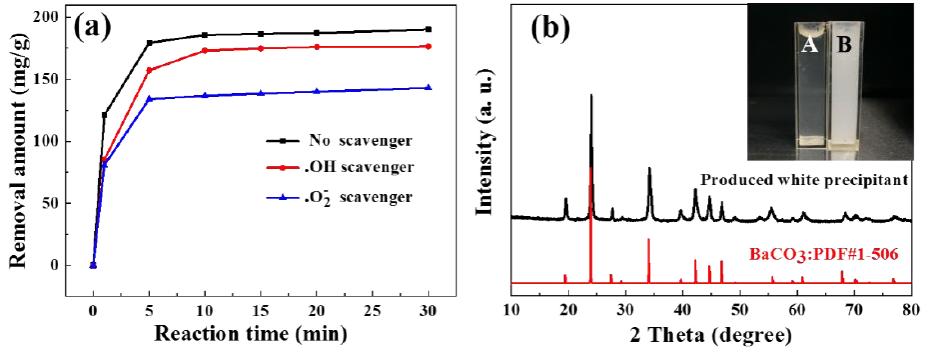
Figure 7. The effects of scavengers on the degradation of TC with MnO/CNTs under MI ( a ); XRD patterns of the white precipitation formed in Ba(OH) 2 solutions ( b ). Insert: picture of Ba(OH) 2 solutions after treatment. Gas produced by only H 2 O with MI (A) and gas produced by TC degradation with MI (B) passed through Ba(OH) 2 solutions.